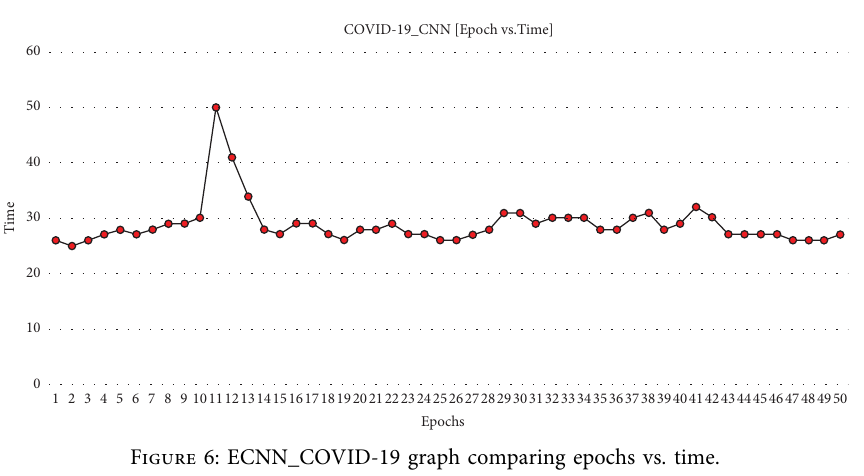
Figure 6: ECNN_COVID-19 graph comparing epochs vs. time.